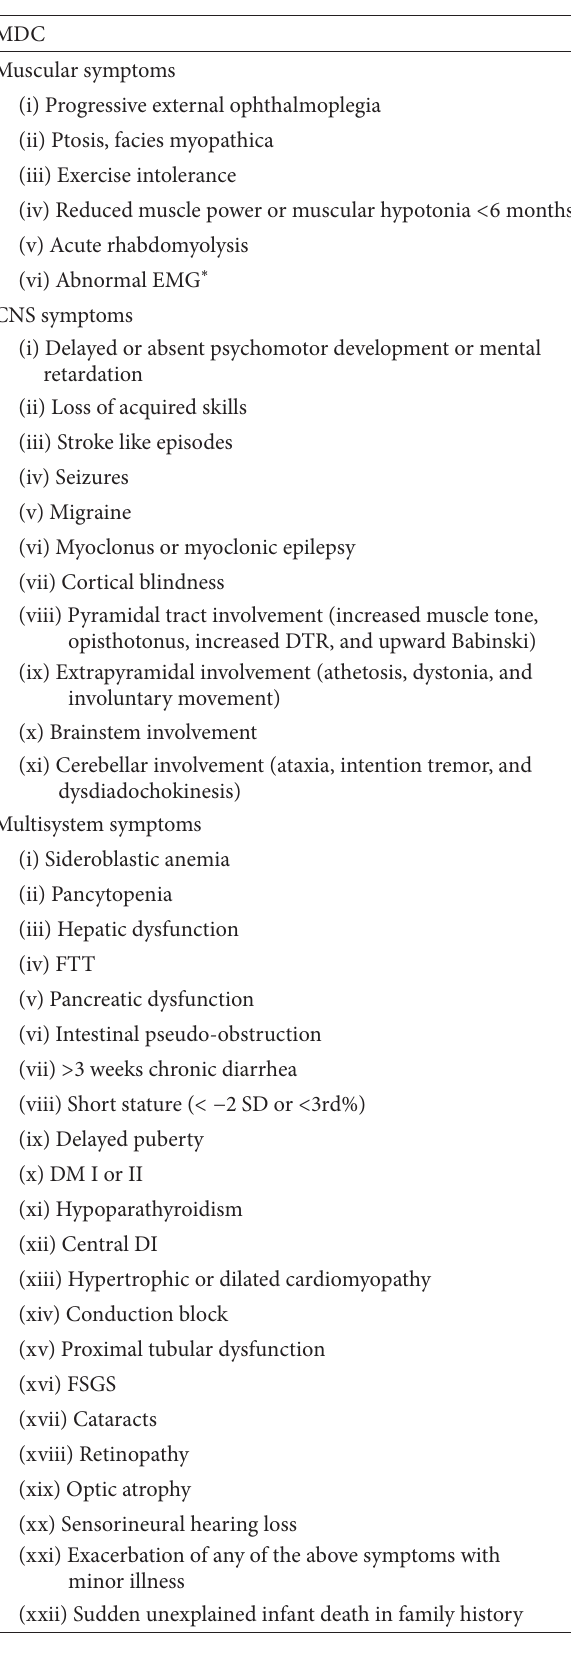
Table 1: Modified mitochondrial disease criteria and Enquˆete P´erinatale